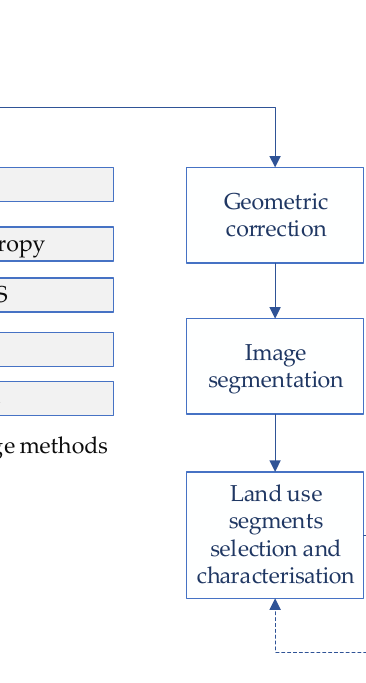
Figure 1. Methodology of the study.